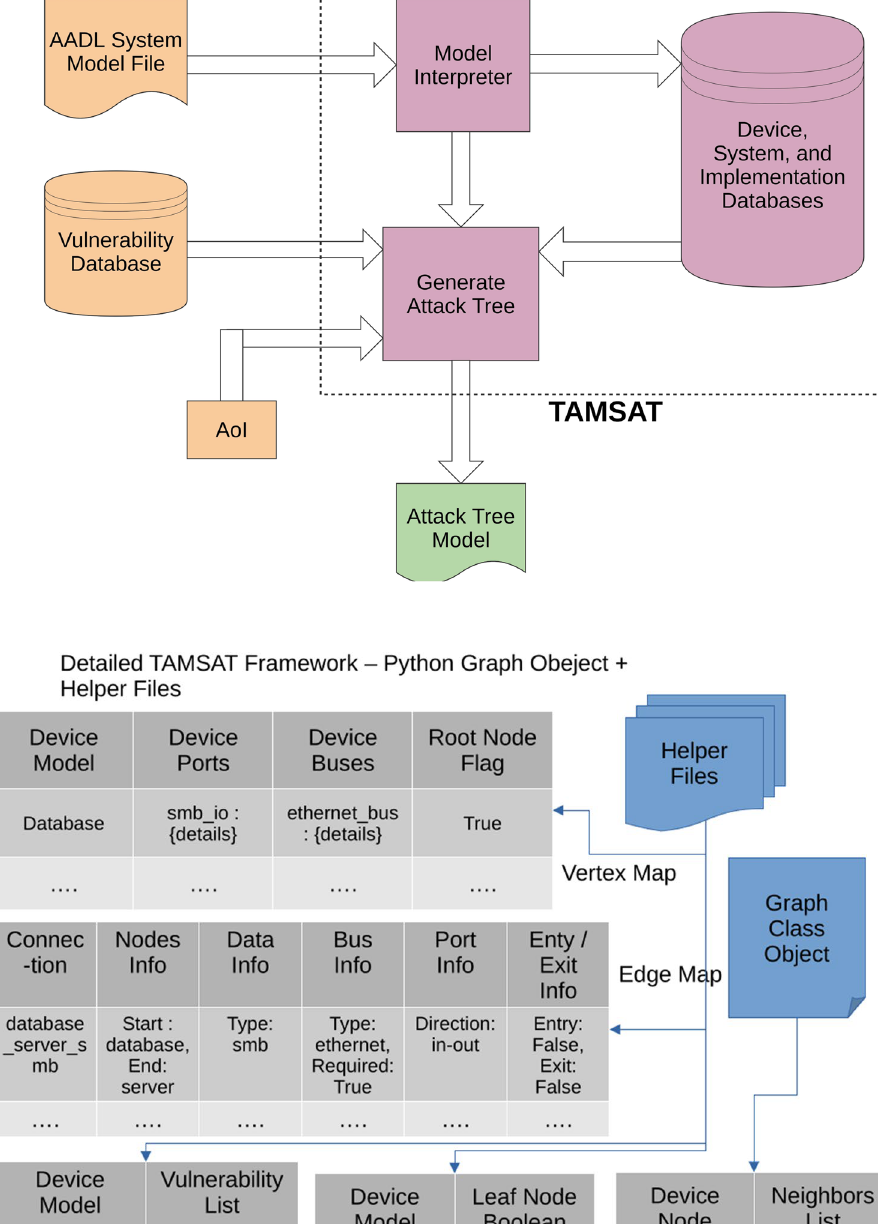
Fig. 6 Illustration of TAMSAT flow graph [35]